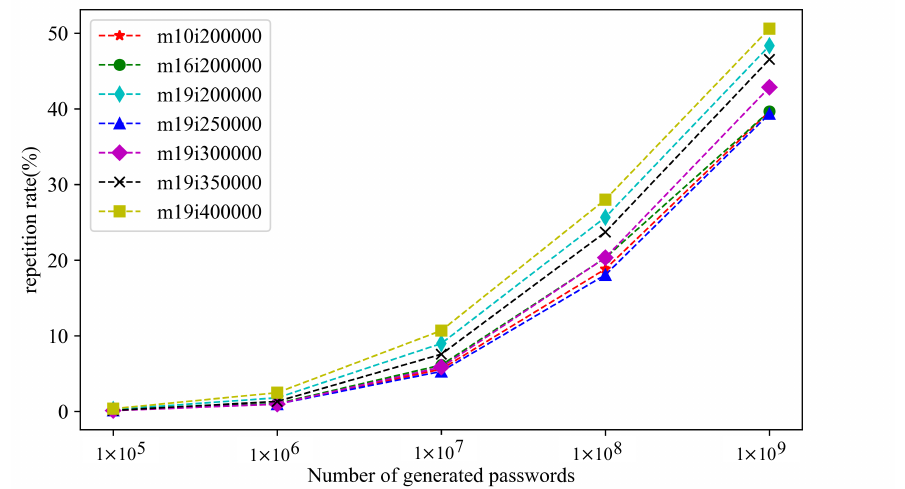
Figure 5. Effects of training rounds on the repetition rate of